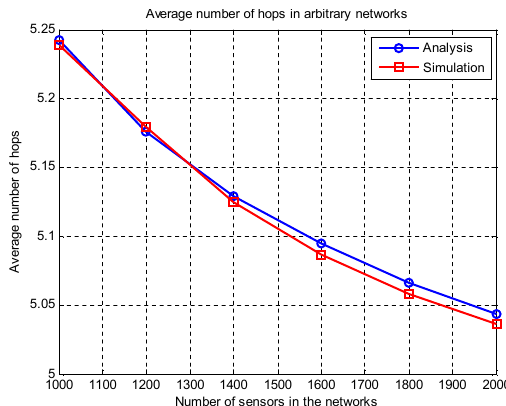
readings from each cluster are added up together and there are only a certain number of measurements are sent to the BS directly, denoted as DCCS. In